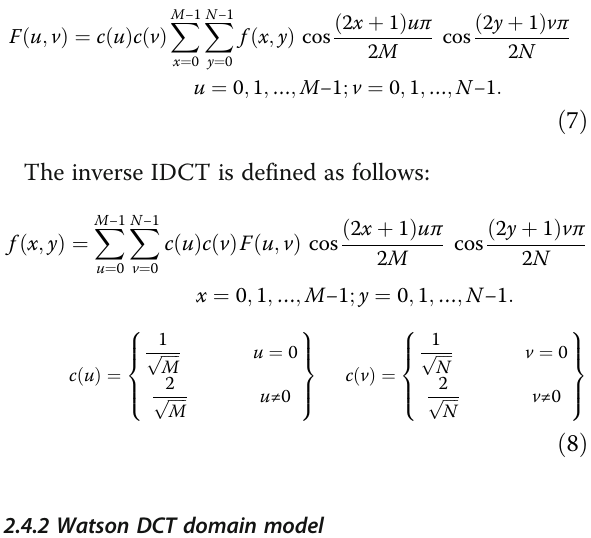
3 Method: The proposed DRM misusing detection scheme based on watermark